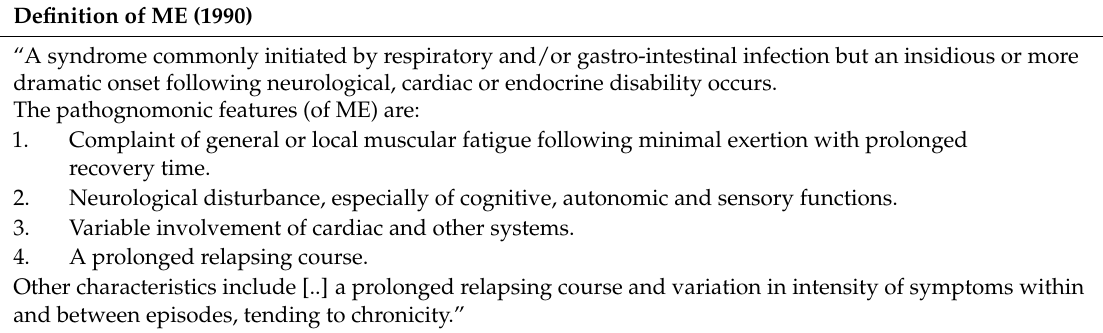
Table 1. The most recent formal definitions of ME (1990)